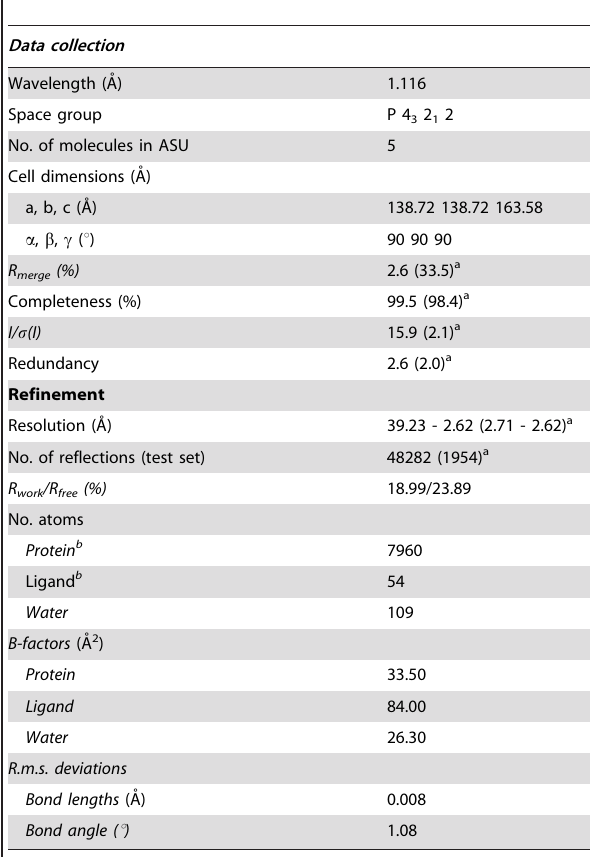
Table 1. Data collection and refinement statistics.